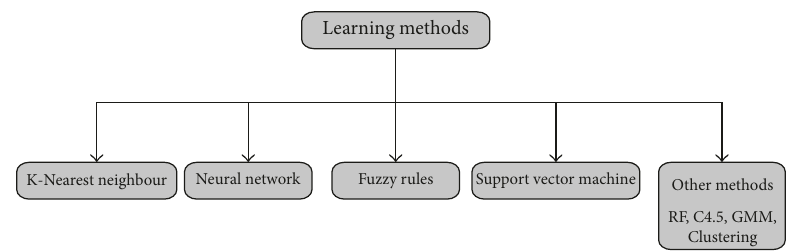
Figure 3: State-of-the-art